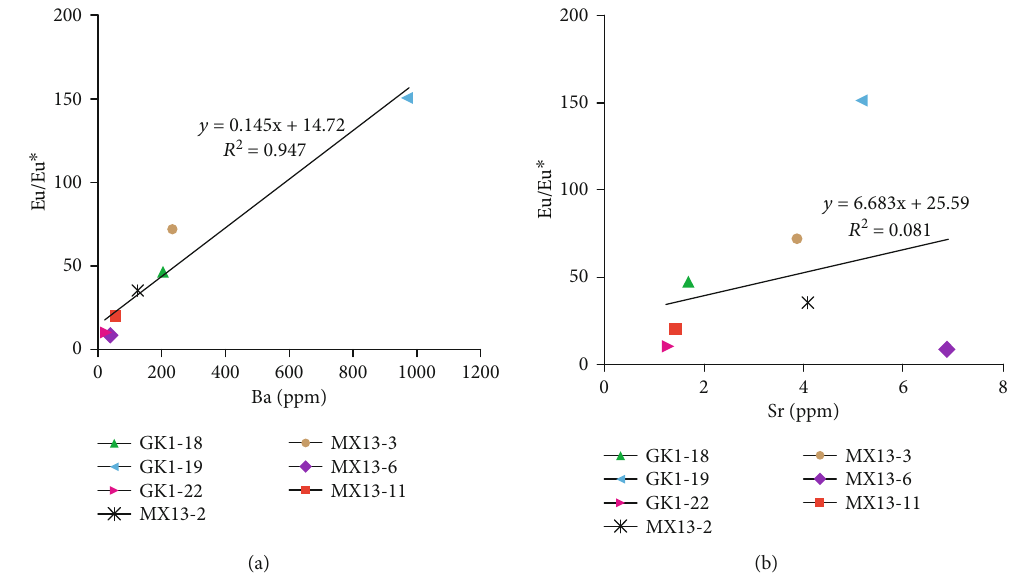
Figure 12: Eu/Eu ∗ versus the concentrations of (a) Ba and (b) Sr of the Upper Ediacaran reservoir solid